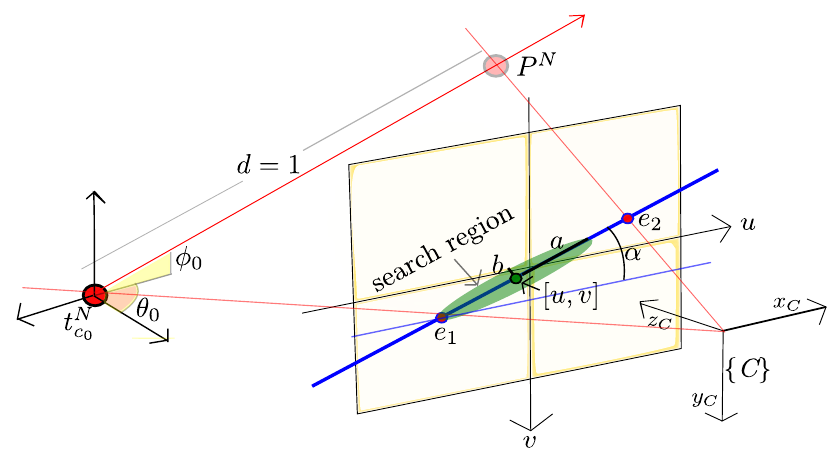
Figure 5. The established search region to match candidate points is constrained to ellipses aligned with the epipolar